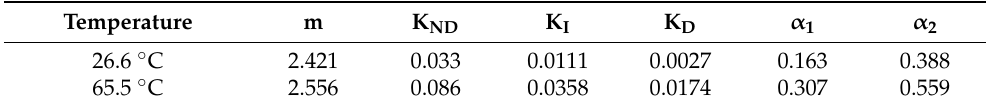
Table 1. Calculation results of hydration parameters.